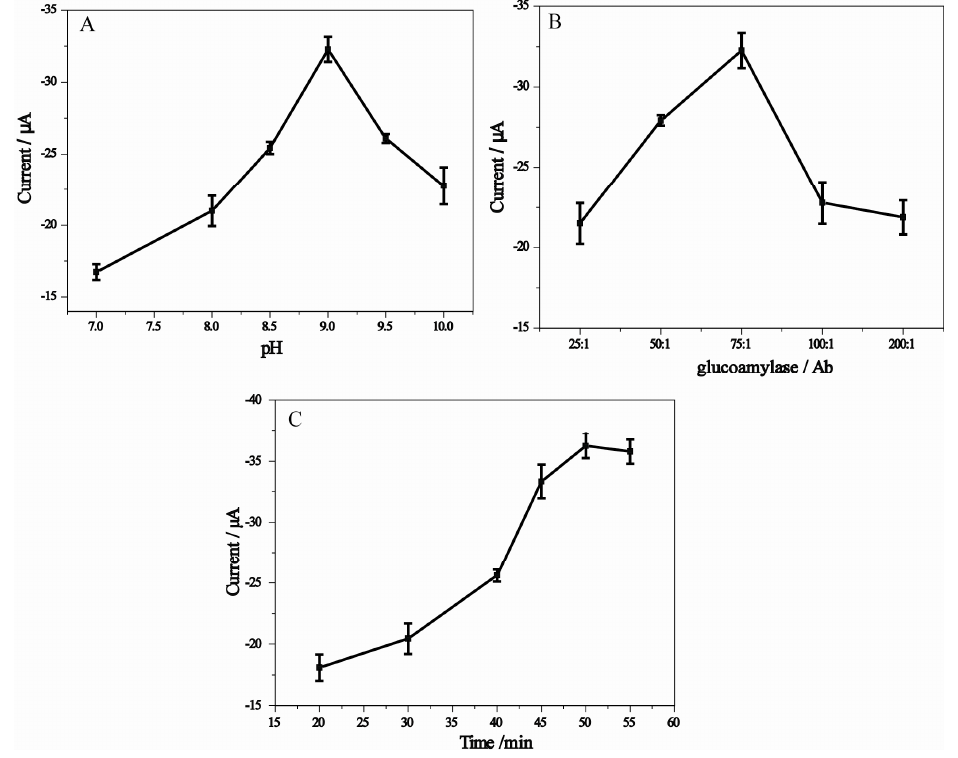
to AuNPs. ( B ) Effect 2